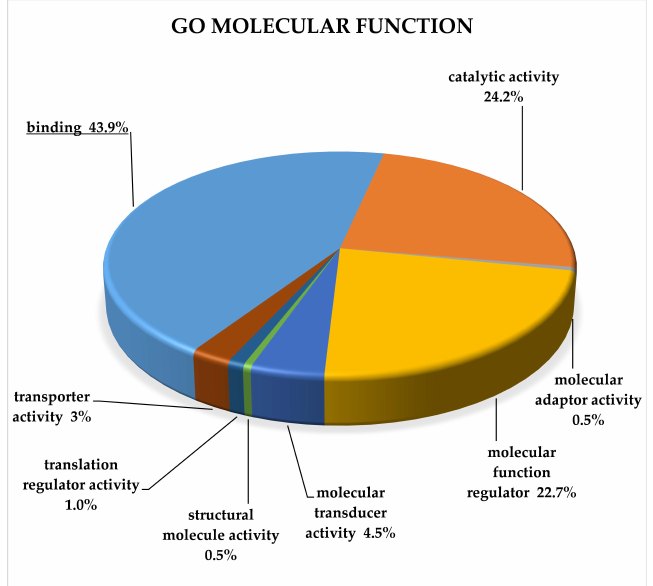
Figure 2. GO-Slim analysis of target genes of up-regulated miRNAs in CRC. Classification is accord- ing to molecular function terms, and all terms are plotted. The significantly overrepresented term is underlined ( p < 0.001; FDR < 0.001). FDR—false discovery rate.